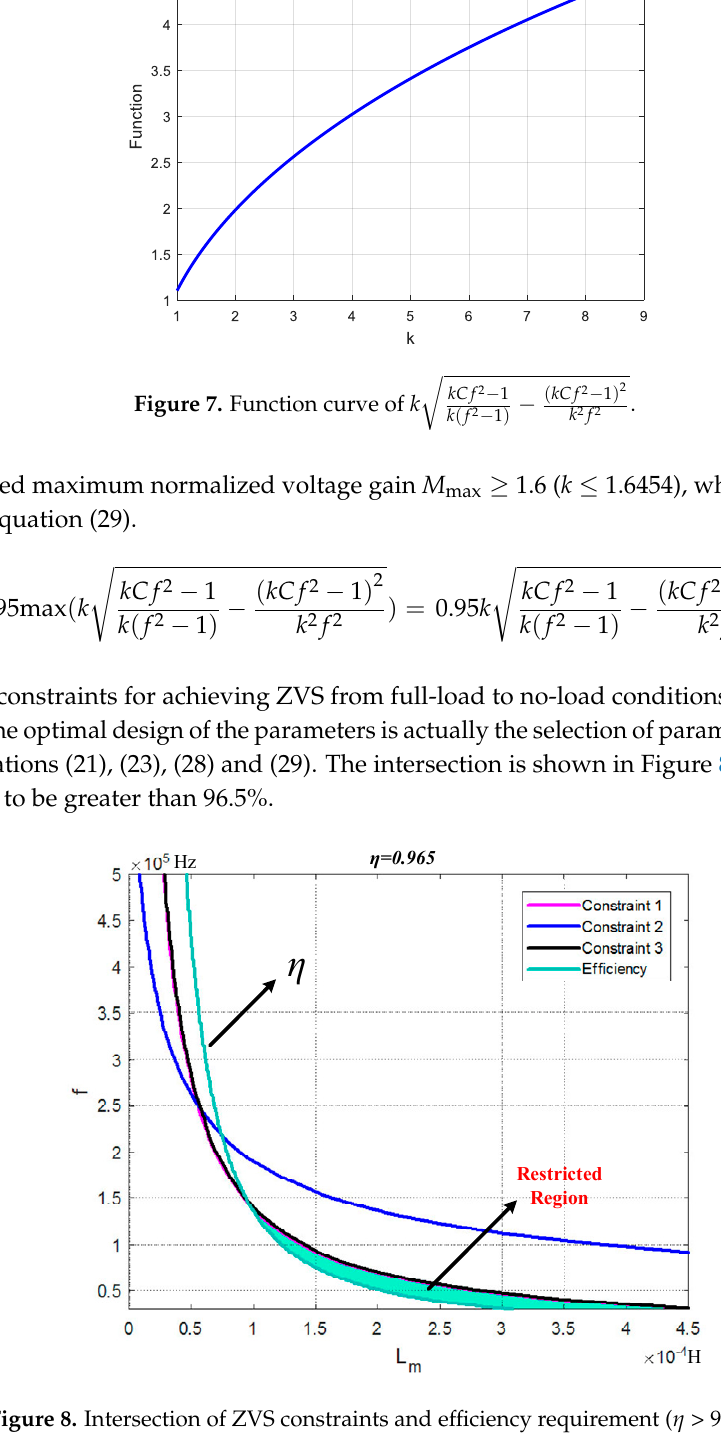
Figure 6. Simplified time-domain gain curves of different k values in PO mode.